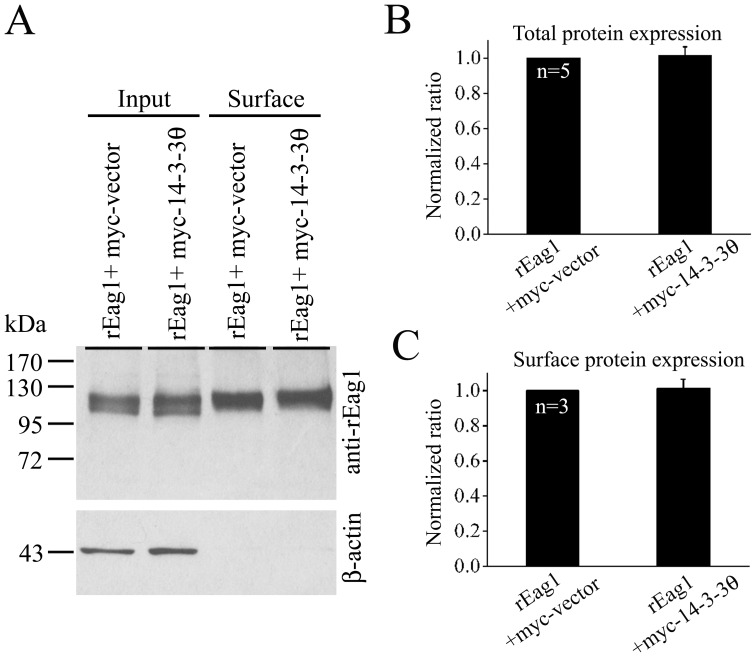
Lack of effect of 14-3-3θ over-expression on the total and surface expression of rEag1 protein.
(
A
) Representative result of surface biotinylation experiments. Intact HEK293T cells were biontylinated on ice and thereafter solubilized. (Surface) Cell lysates were pulled down with streptavidin agarose beads, followed by immunoblotting with the anti-rEag1 antibody. (Input) Cell lysates were directly employed for immunoblotting analyses. Input represents 5% of the total protein used for streptavidin pull-down. Also shown at the bottom are the corresponding β-actin expression levels for each lane. The specificity of the biotinylation procedure was verified by the absence of β-actin bands in the surface fraction. (
B
) Quantification of total and surface expression of rEag1 in the absence or presence of 14-3-3θ over-expression. The total protein density (top panel) was determined as the ratio of input signal to the cognate β-actin signal. The surface expression efficiency (bottom panel) was expressed as the ratio of surface signal to the corresponding total protein density. The mean values were subsequently normalized with respect to that of vector control. Densitometric scans of immunoblots were obtained from three independent experiments.